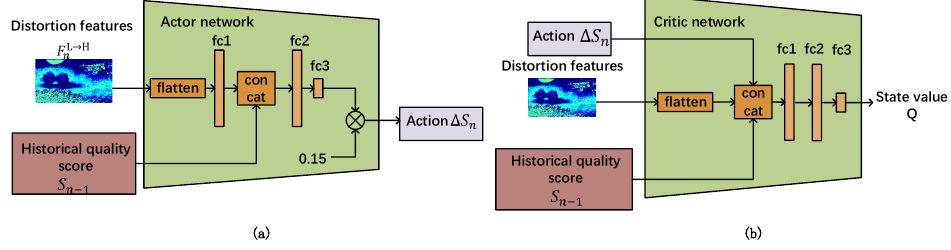
Figure 7. ( a ) The network structure of the actor network. ( b ) The network structure of the critic